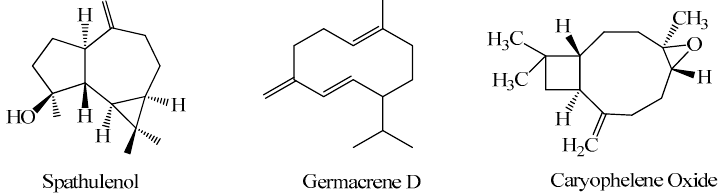
Figure 2. Chemical structures of the volatile components in Anacyclus pyrethrum .